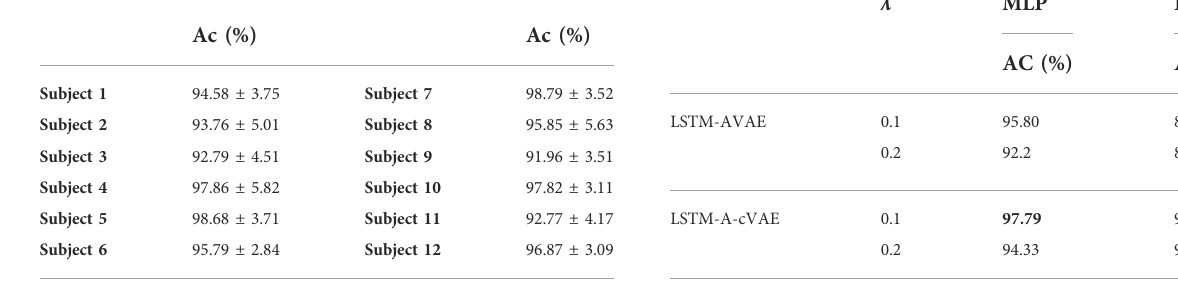
TABLE 3 Subject-speci fi c classi fi cation accuracy results of LSTM- AVAE with MLP classi fi er.